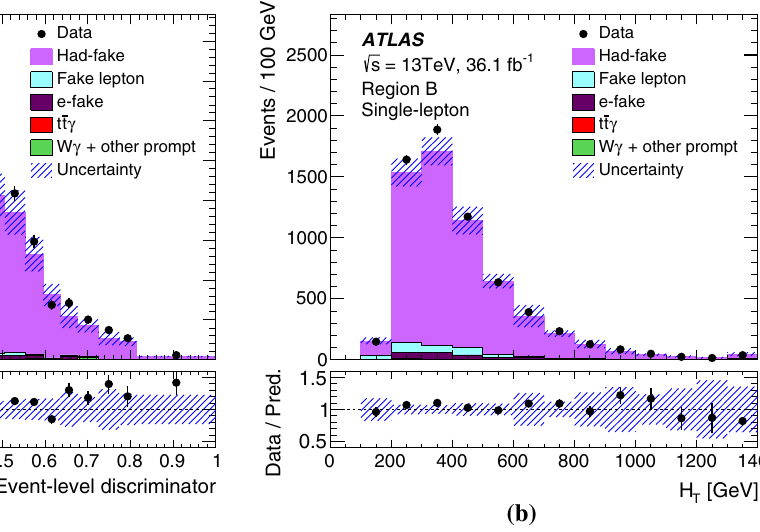
Fig. 16 Distributions of the a ELD and b H T in the hadronic-fake con- trol region B of the single-lepton channel. Data-driven correction to the electron-fake background and all systematic uncertainties are included.